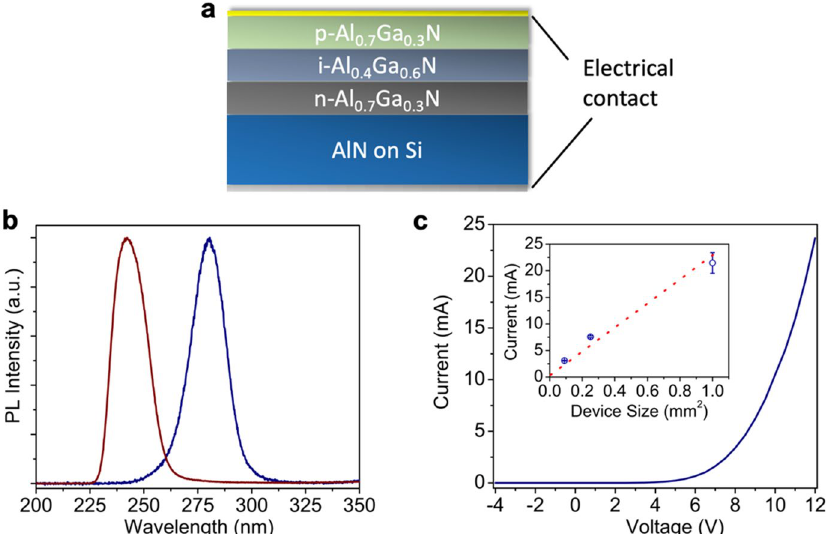
Figure 3. ( a ) Schematic of the AlGaN DH LED structure grown on top of the AlN buffer layer on Si. The electrical contacts are also shown. ( b ) Room-temperature PL spectra of the AlGaN active region and cladding layers. ( c ) I–V characteristics of an AlGaN DH LED with a device size of 1 mm × 1 mm. The inset shows the measured forward currents from devices with various sizes at a forward voltage of 12 V. Numerous devices were tested, and the error bars reflect the current variation from devices with the same